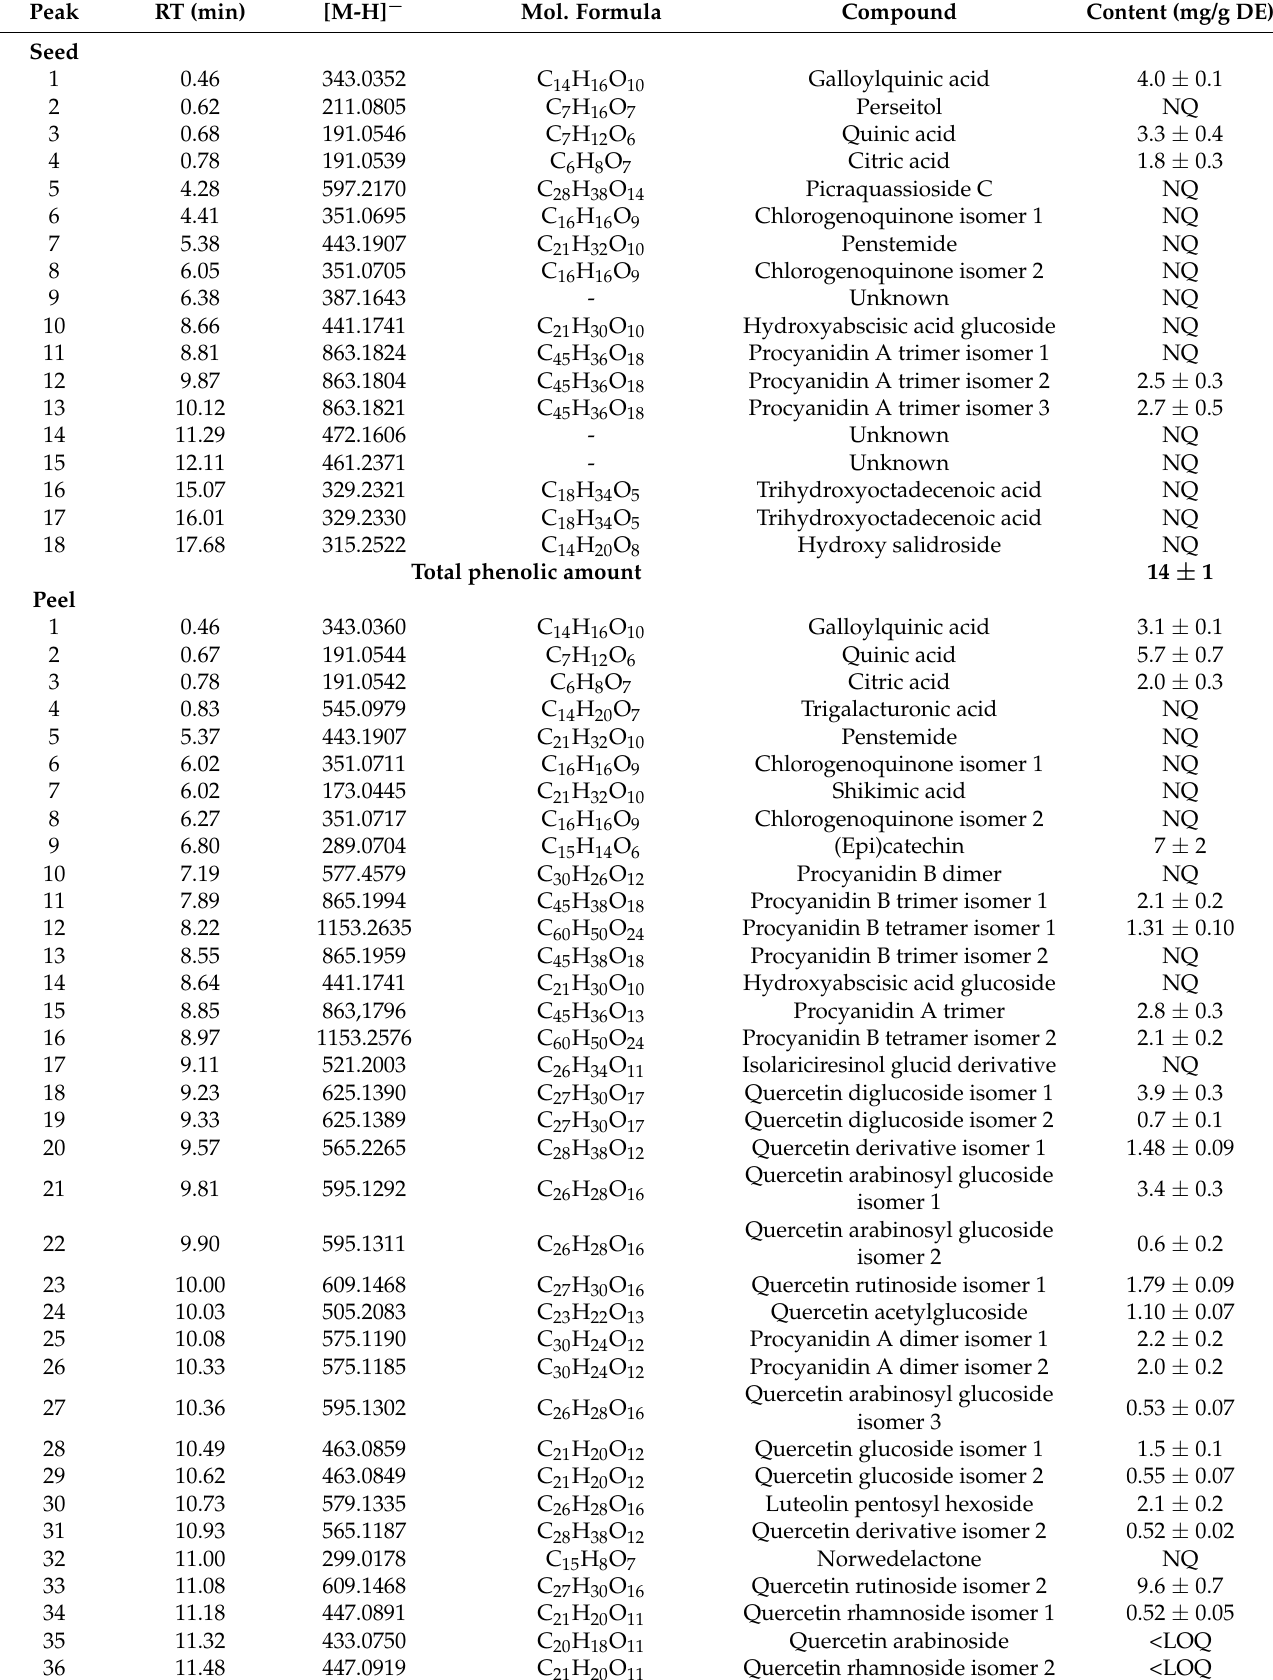
Table 2. Identification and quantification of phytochemical compounds in avocado seed and peel extracts with ethanol/water by